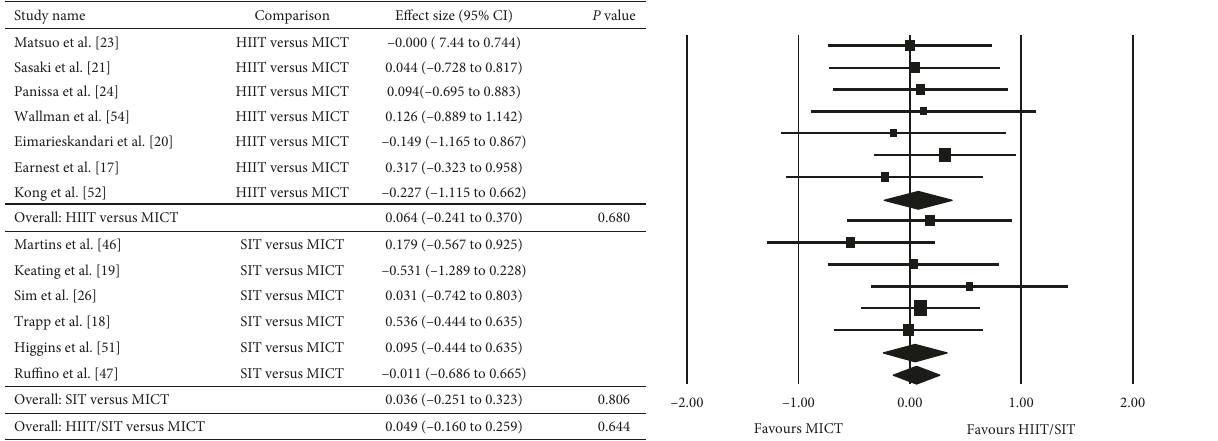
Figure 6: Effect of HIIT/SIT versus MICT on bodyweight. HIIT: high-intensity interval training, SIT: sprint interval training, MICT: moderate-intensity continuous training, and CI: confidence interval.